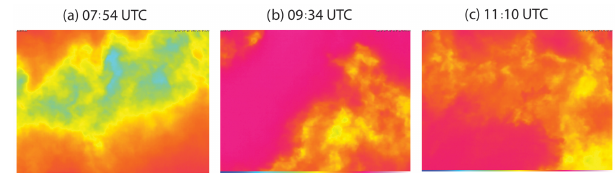
Figure 3. Images from the infrared cloud camera at Savé on 5 July 2016 (Derrien et al., 2016) for the times indicated. The im- ages from the camera are coded in RGB colours (red, green, and blue), providing a qualitative estimate of cloud cover during the day and night. The image colour is dependent on the emissivity of the sky and consequently on the brightness temperature, such that red indicates warm and blue